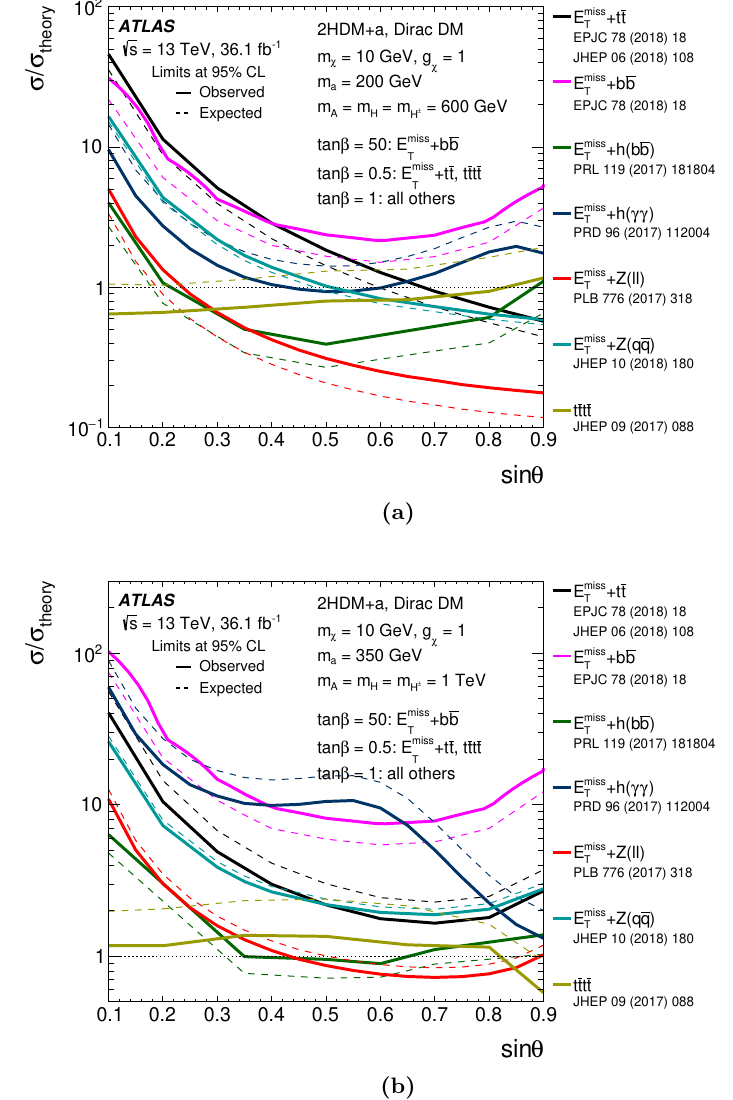
Figure 20. Observed exclusion limits for the 2HDM+ a model as a function of sin (cid:18) , following the two parameter choices of scenario 3, (a) low-mass and (b) high-mass a hypotheses. The limits are calculated at 95% CL and are expressed in terms of the ratio of the excluded cross-section to the nominal cross-section of the model.